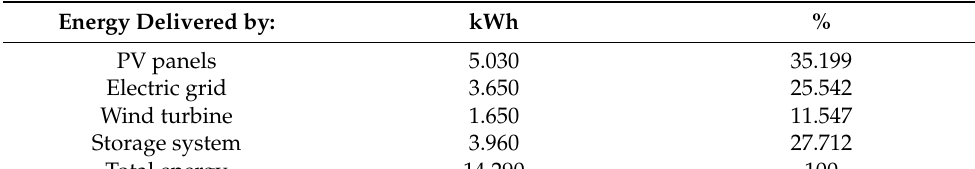
Table 3. The amount of energy used for consumption—second scenario.